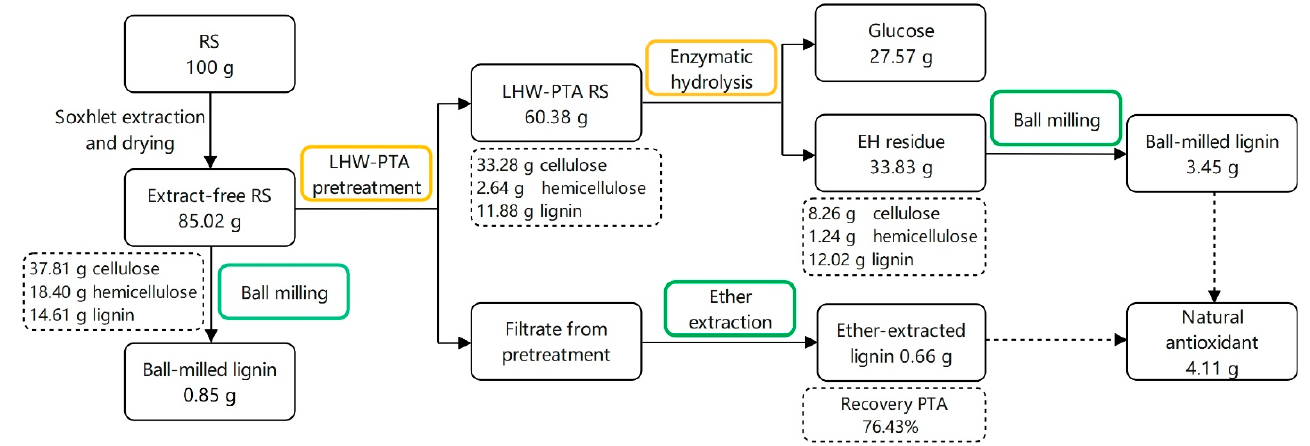
Figure 4. The mass balance diagram of the extraction process of rice straw lignin.